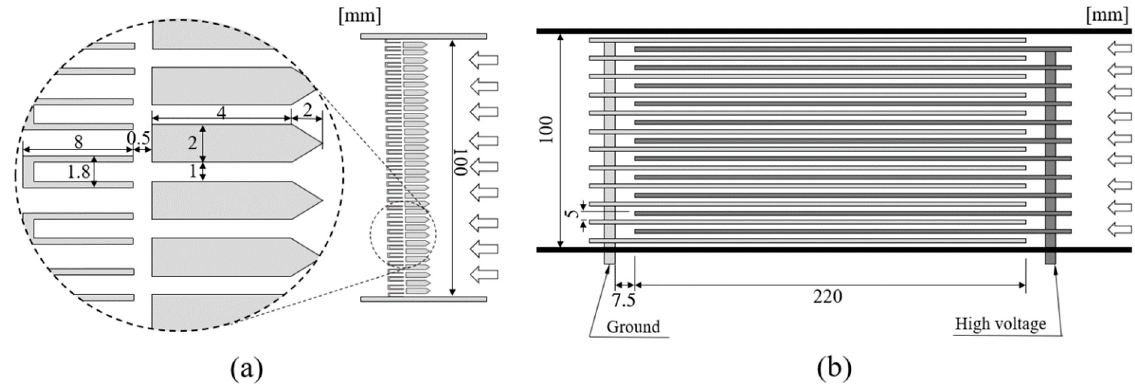
Figure 1. Schematics of ( a ) the inertial separator and ( b ) the electrostatic precipitator (ESP).